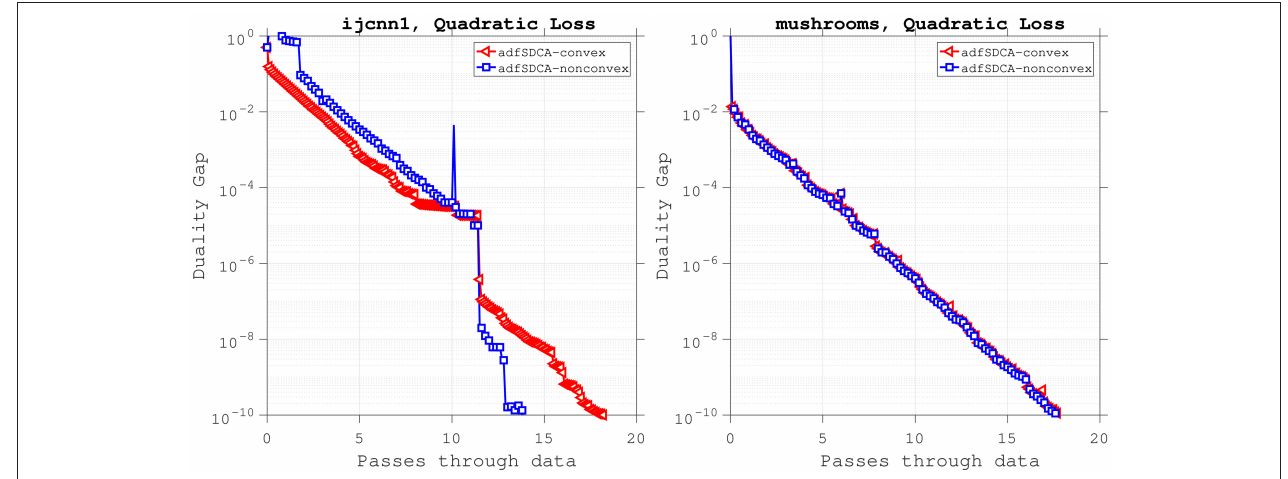
FIGURE 6 | Investigating the performance of adfSDCA when every loss function is convex, and when only the average of the loss functions is